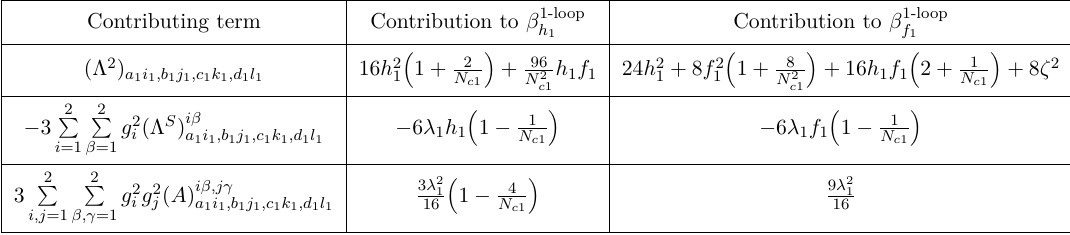
and β 1-loop h 1 f